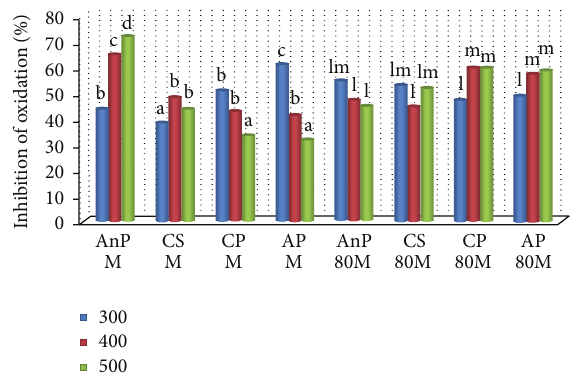
Figure 2: Inhibition of LDL oxidation by different plant extracts.